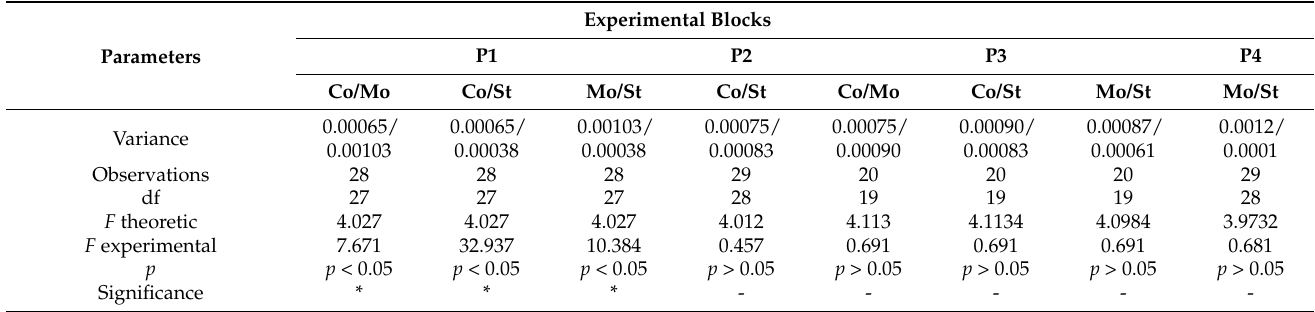
Table 3. Result summary of ANOVA significance tests between the three variants (Co, Mo, St) of the experimental blocks (P1, P2, P3, P4) for density.